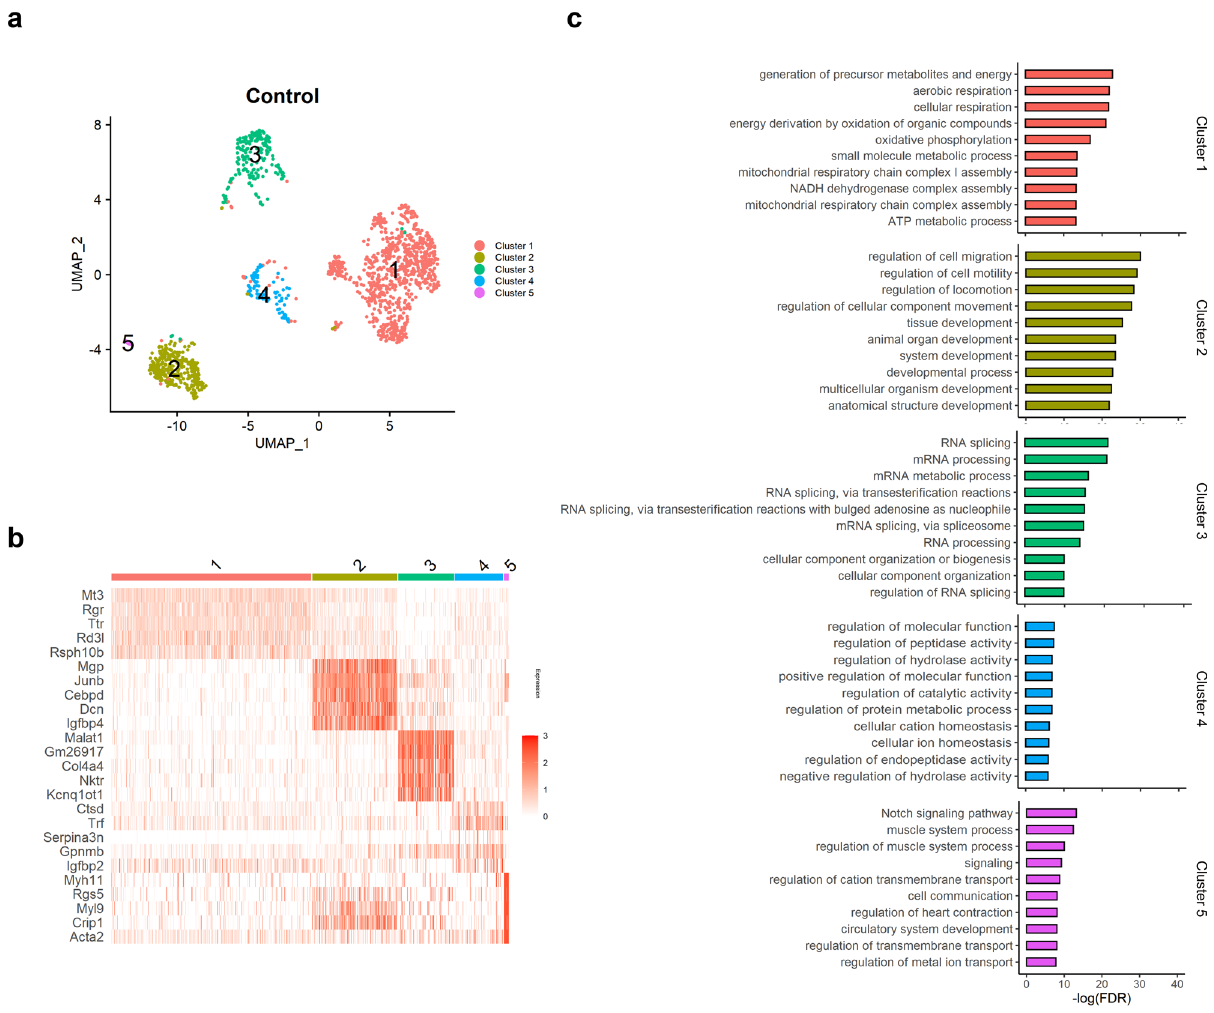
Fig. 2 RPE subpopulations in control mice display speci fi c functional transcriptomic signatures. a UMAP plot displaying RPE cells from control mice ( n = 5). Each dot represents a single cell ( n = 1531). Colorization was performed according to the original unsupervised clustering performed by Seurat. b Heatmap showing the three most DEGs of each cell cluster, as provided by Seurat. Each column represents a single cell, and each row represents an individual gene. Five marker genes per cluster are shown on the left, sorted by p value. Red indicates maximum gene expression, and white indicates no expression in scaled log-normalized UMI counts. c Top 10 enriched GO terms in each control RPE subpopulation, sorted by p value. Control = control mouse RPE